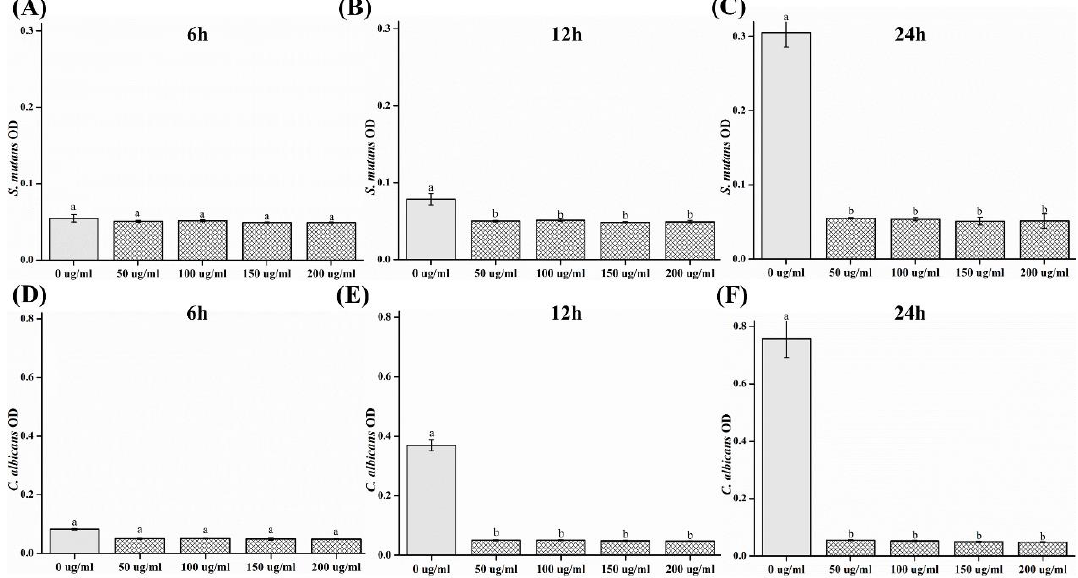
Figure 3. Comparison of optical density (OD) of ( A ) S. mutans , 6 h; ( B ) S. mutans , 12 h; ( C ) S. mutans , 24 h; ( D ) C. albicans , 6 h; ( E ) C. albicans , 12 h; and ( F ) C. albicans , 24 h. Different letters above bars indicate significant differences ( p < 0.05).